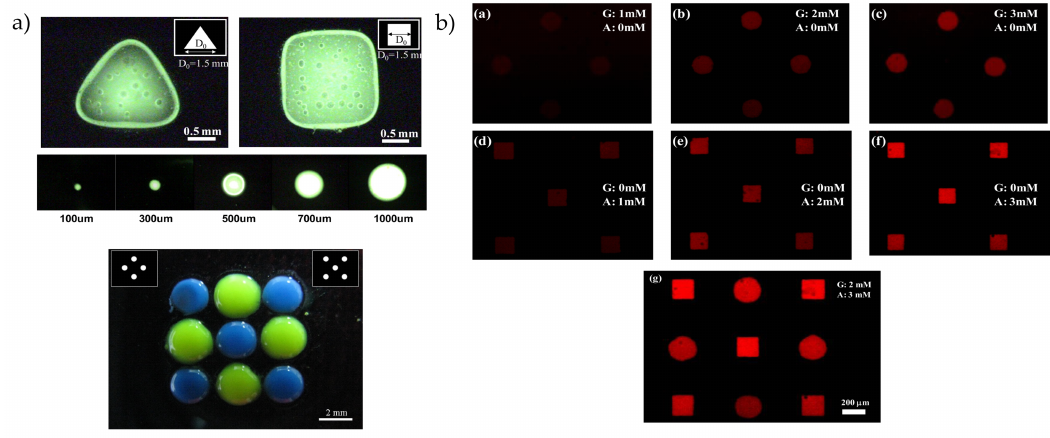
Figure 10. ( a ) Deposition of calcium alginate gels by rear-side illumination of hydrogenated amorphous silicon: In the top image, calcium alginate gels are deposited with different geometries and sizes. In the bottom image, the gels are deposited sequentially with two different micropatterns. ( b ) Patterning of chitosan with different geometries by rear-side illumination of an amorphous silicon photocathode: In the circular structure, glucose oxidase, peroxidase, and amplex red is added, while in the quadraric structure, alcohol oxidase is added instead of glucose oxidase. Adding ethanol or glucose increases the fluorescence intensity of the particular structure. Part (a) is used with permission from Huang et al. [85]